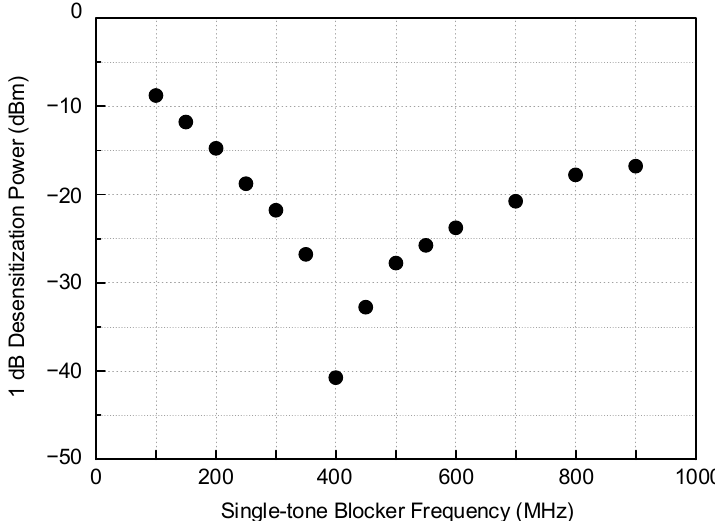
Figure 15. Measured single-tone 1 dB desensitization.